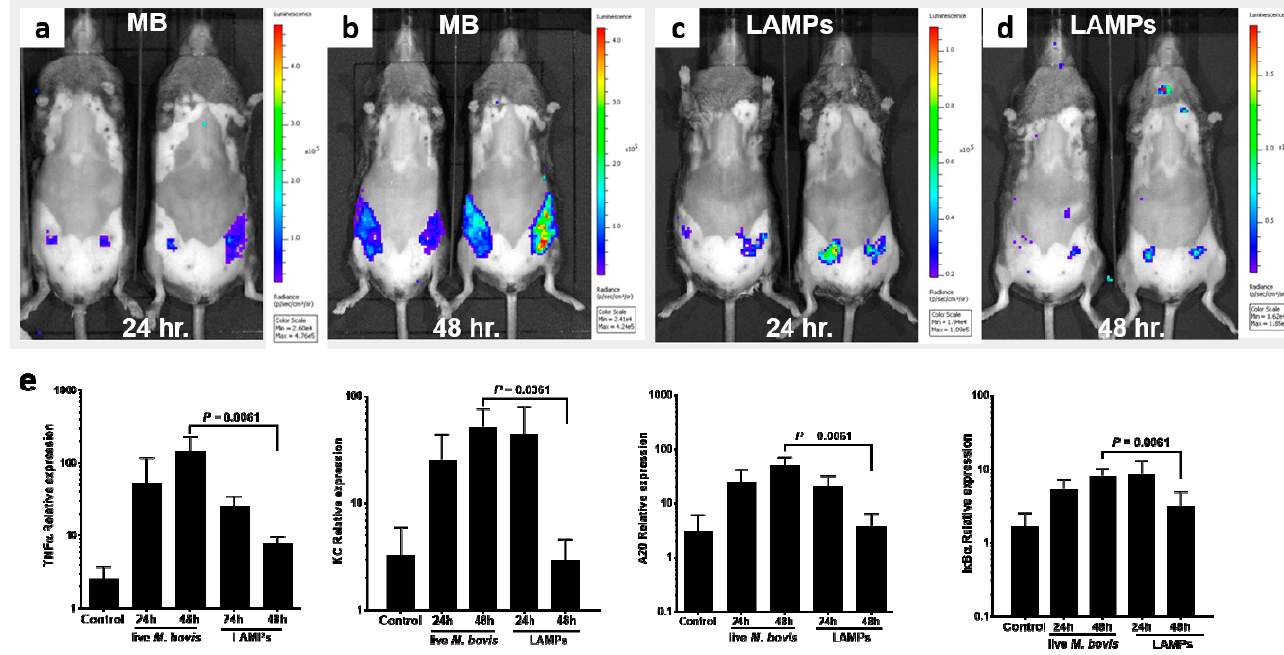
Figure 4. Temporal dynamics and spatial distribution of neutrophil recruitment and inflammation following IMM challenge with live M. bovis and M. bovis- LAMPs. Bioluminescence imaging of neutrophil recruitment was performed in mice challenged with live M. bovis ( a , b ) and LAMPs ( c , d ), 24 h ( a , c ) and 48 h ( b , d ) pi. Relative expression of TNF α , KC, A20, and IkB α genes 24 h and 48 h pi was analyzed using qRT-PCR ( e ).